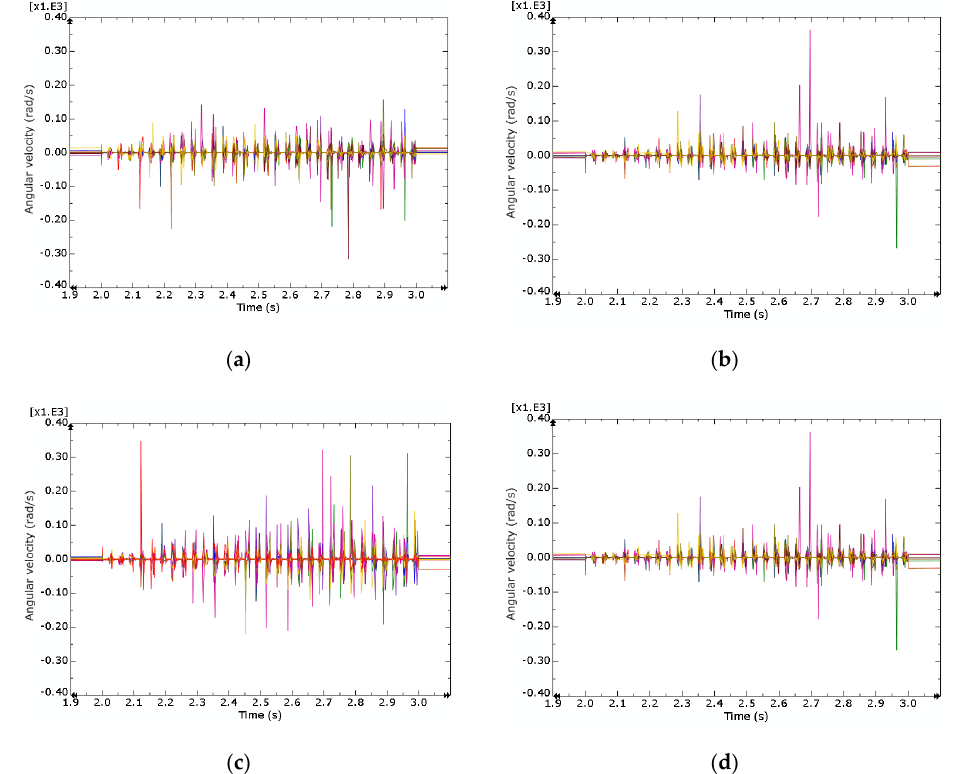
Figure 10. Angular velocity of AC 11 aggregate with a paving speed of 4 m/min: ( a ) in X-direction; ( b ) in Y-direction; ( c ) in Z-direction; ( d ) combined angular velocity.